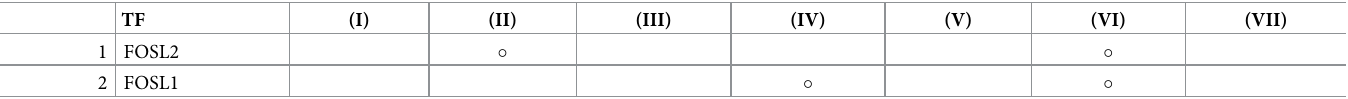
Table 8. Identification of FosL transcription factor (TF) family members within seven TF-related categories in Enrichr. Roman numerals correspond to the first col- umn in Table 3. TF